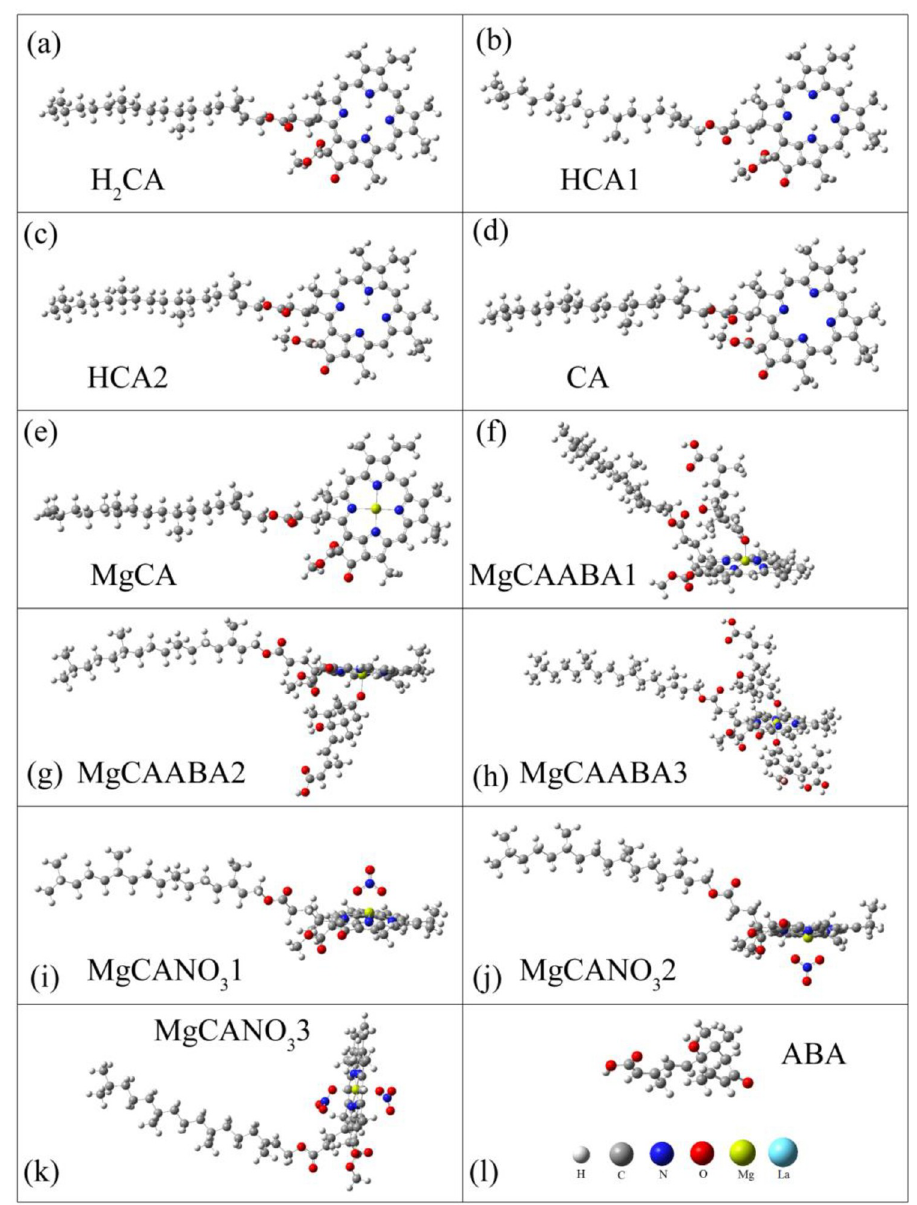
Fig 3. Optimized structures for the reactions between NO , ABA and Mg-chlorophyll A. (a) Free-base chlorophyll 3 (cid:0) A (H 2 CA), (b-c) monodeprotonated free-base chlorophyll A (HCA1 and HCA2), (d) dideprotonated free-base chlorophyll A (CA), (e) Mg-chlorophyll A (MgCA), (f-h) abscisic acid (ABA) adsorbed onto Mg-chlorophyll A (MgCAABA1, MgCAABA2, and MgCAABA3), (i-k) NO adsorbed onto Mg-chlorophyll A (MgCANO 3 1, 3 (cid:0) MgCANO 3 2, and MgCANO 3 3) and (l) abscisic acid (ABA). For the MgCA + ABA reaction, one ABA molecule could be adsorbed onto either side of the chlorin ring, or two ABA molecules could be adsorbed onto both sides of the chlorin ring at the same time. Therefore, three compounds (MgCAABA1, MgCAABA2, and MgCAABA3) could ) reaction, both La and NO could react with MgCA. be produced. For the MgCA + La(NO 3 3 3 (cid:0) The reaction of MgCA + NO was very similar to the MgCA + ABA reaction; therefore, three 3 (cid:0) compounds (MgCANO 1, MgCANO 2, and MgCANO 3) were obtained. For the reaction of 3 3 3